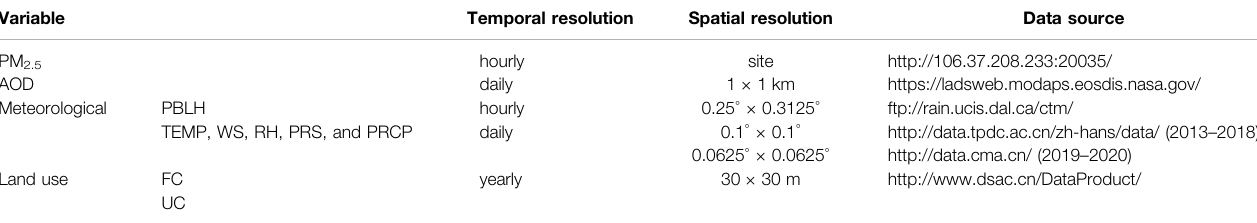
TABLE 1 | Information about data source, temporal and spatial